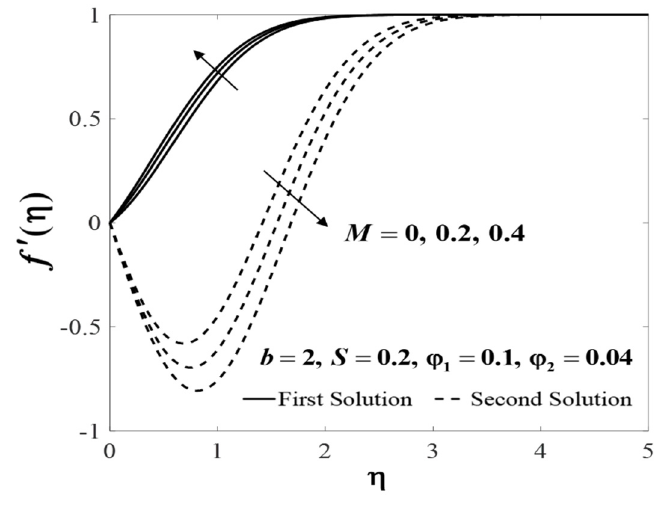
Figure 12. Impact of 𝑀 on 𝑓 ′ (𝜂) .